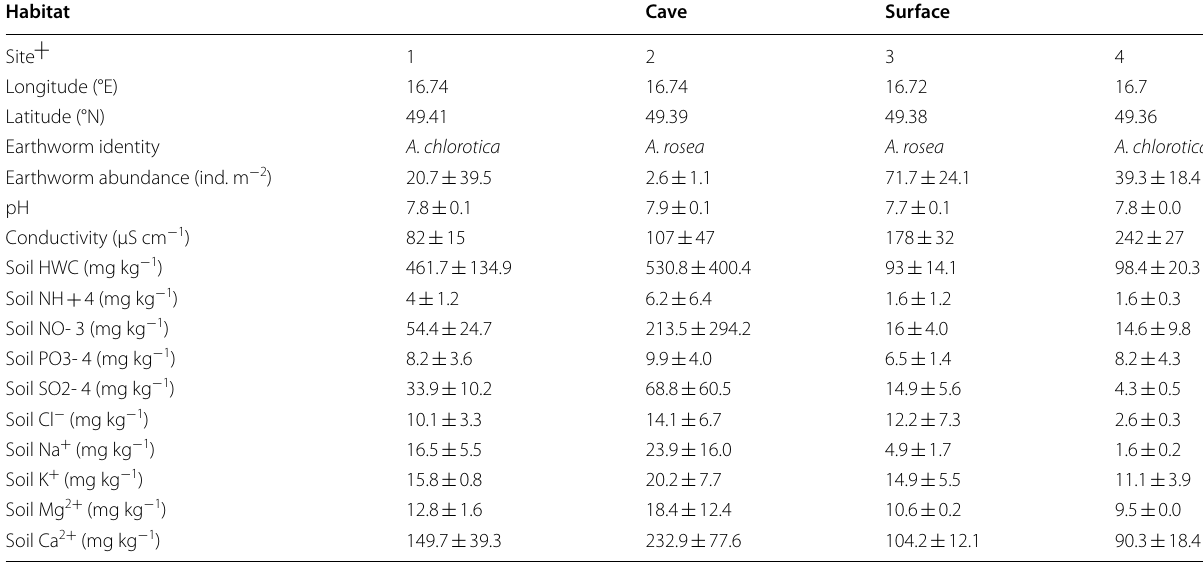
Table 1 Abundance of earthworms ( Allolobophora chlorotica and Apporrectodea rosea ) and the soil properties in caves and surfaces. Values are presented as mean SD ±